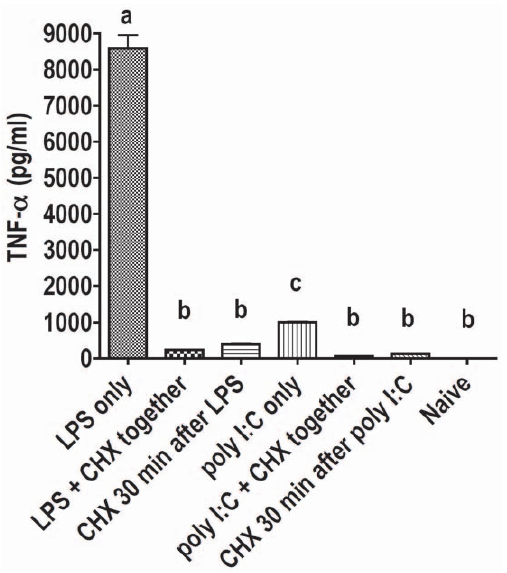
Figure 1. Mouse TNF- a ELISA assay from cell culture superna- tants. Each group contained 6 samples. Cells were treated with LPS/ poly I:C alone, with cycloheximide and LPS/poly I:C at the same time point, or with LPS/poly I:C first and cycloheximide 30 min later. Naive, untreated cells served as control. Bars with no shared letters are significantly different (p ,